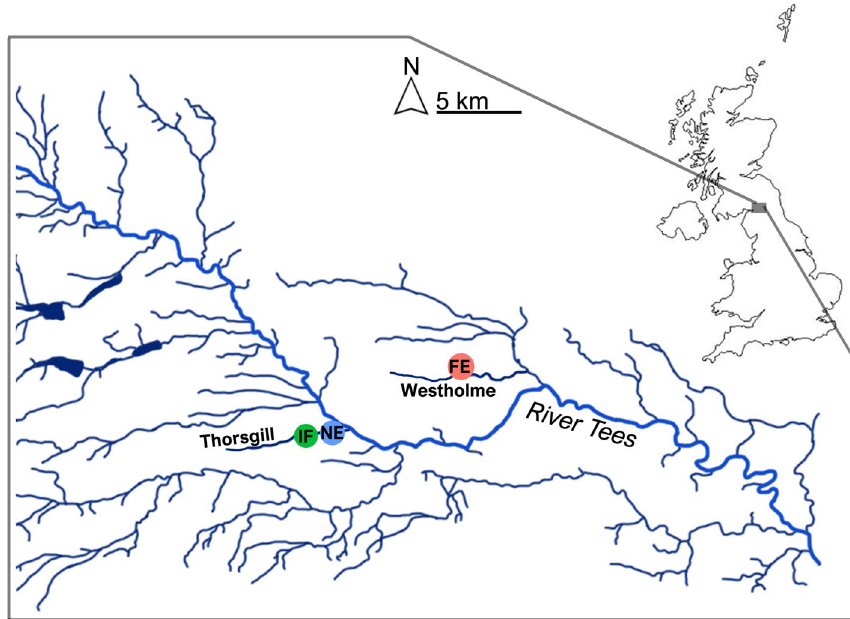
Figure 1. Map of the study locations of invasive crayfish dispersal in the River Tees catchment, northeast England. FE fully-established, NE newly-established, IF invasion